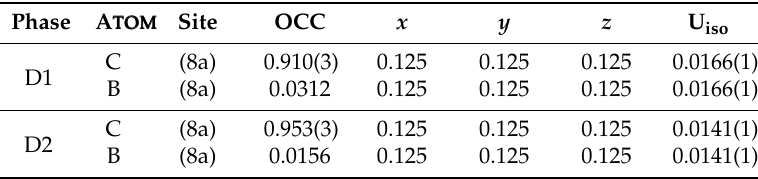
Table 3. Fractional atomic coordinates, site occupancy, and isotropic displacement parameters U iso (Å 2 ) for D1 and D2 (Sample